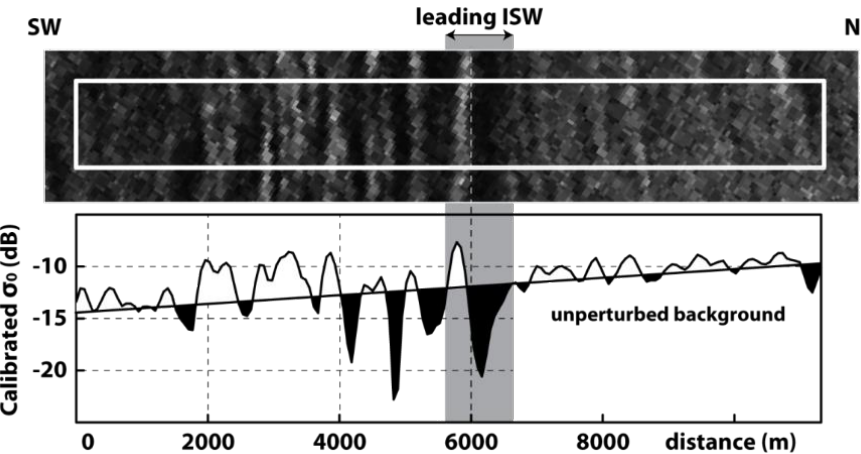
Figure 4. The top panel is a zoom in of the white rectangle in Figure 3b. The bottom panel is a transect along the white rectangle on top (extending approximately from the southwest to the northeast), showing a calibrated backscatter cross-section across a mode-2 ISW-like feature (leading wave highlighted in a grey background). The black line is a linear best fit used to illustrate signal modulation above (in white) and below (in black) a representative local average.